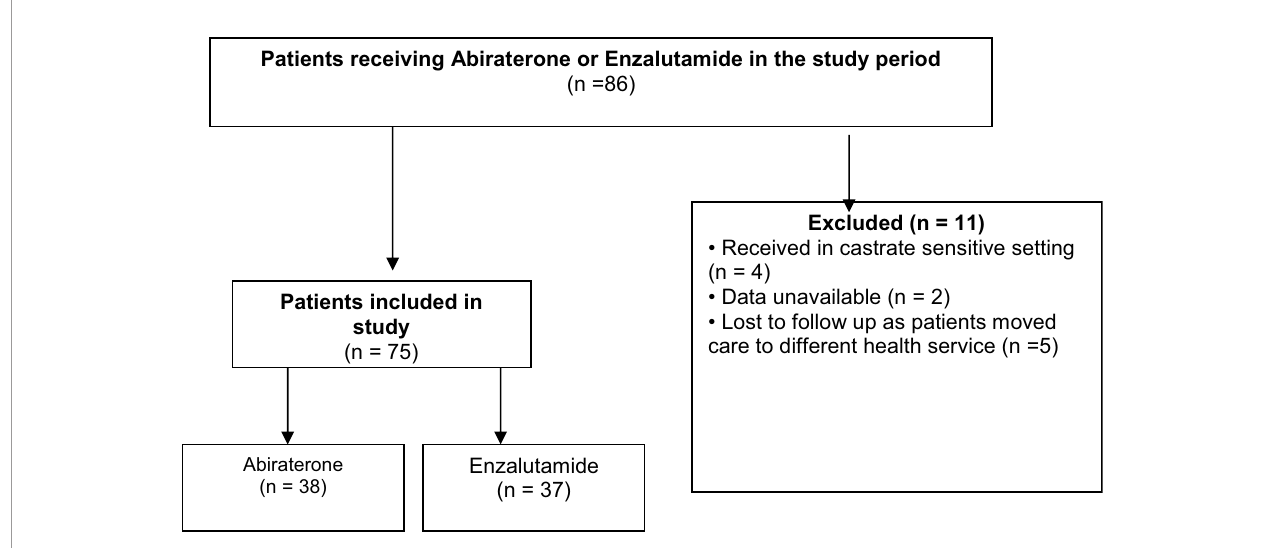
FIGURE 1 | CONSORT diagram.